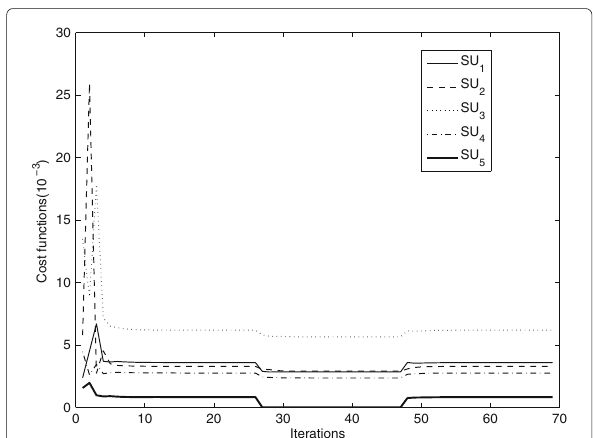
Fig. 9 The variations of cost functions versus the number of iterations for a variable number of SUs